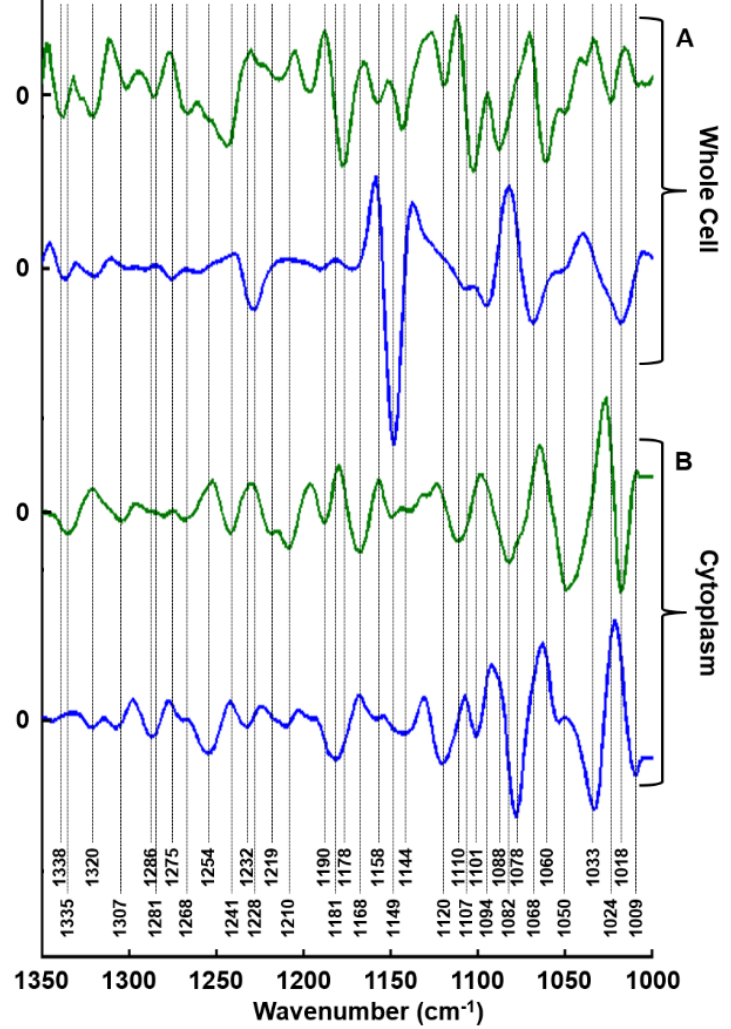
Figure 6. Comparison of first two principal components corresponding to: ( A ) whole cell imaging and ( B ) synchrotron-FTIR microspectroscopy of the cytoplasm. PC1 (blue line) and PC2 (green line).